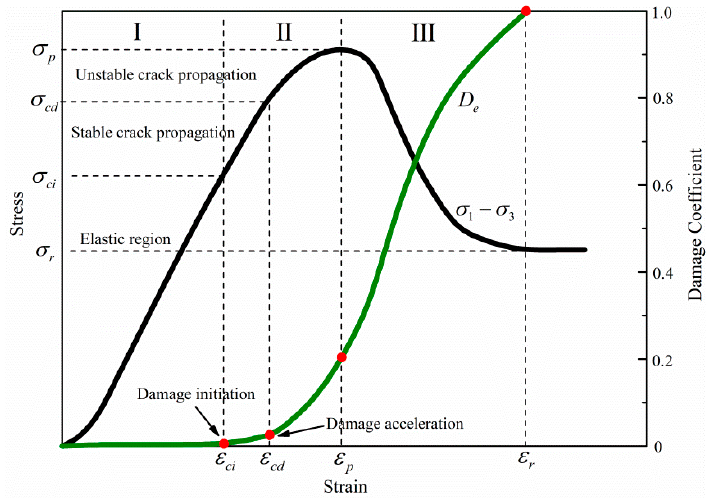
Figure 5. Schematic diagram of damage evolution over the entire process of rock failure.